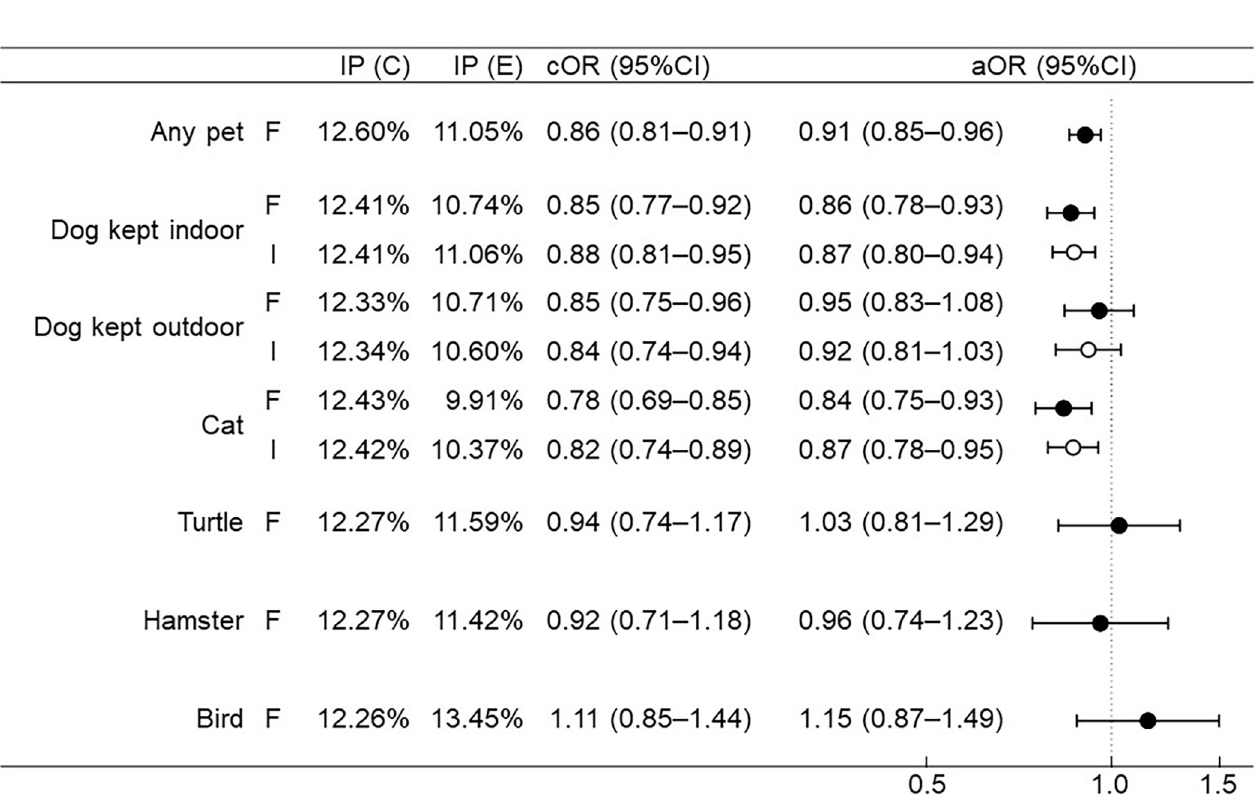
Fig 2. Association between pet exposure and the incidence risk of food allergies until 3 years of age. F, fetal (black circles); I, during early infancy (white circles); IP (C), incidence proportion (control); IP (E), incidence proportion (exposed); cOR, crude odds ratio; aOR, adjusted odds ratio; CI, confidence